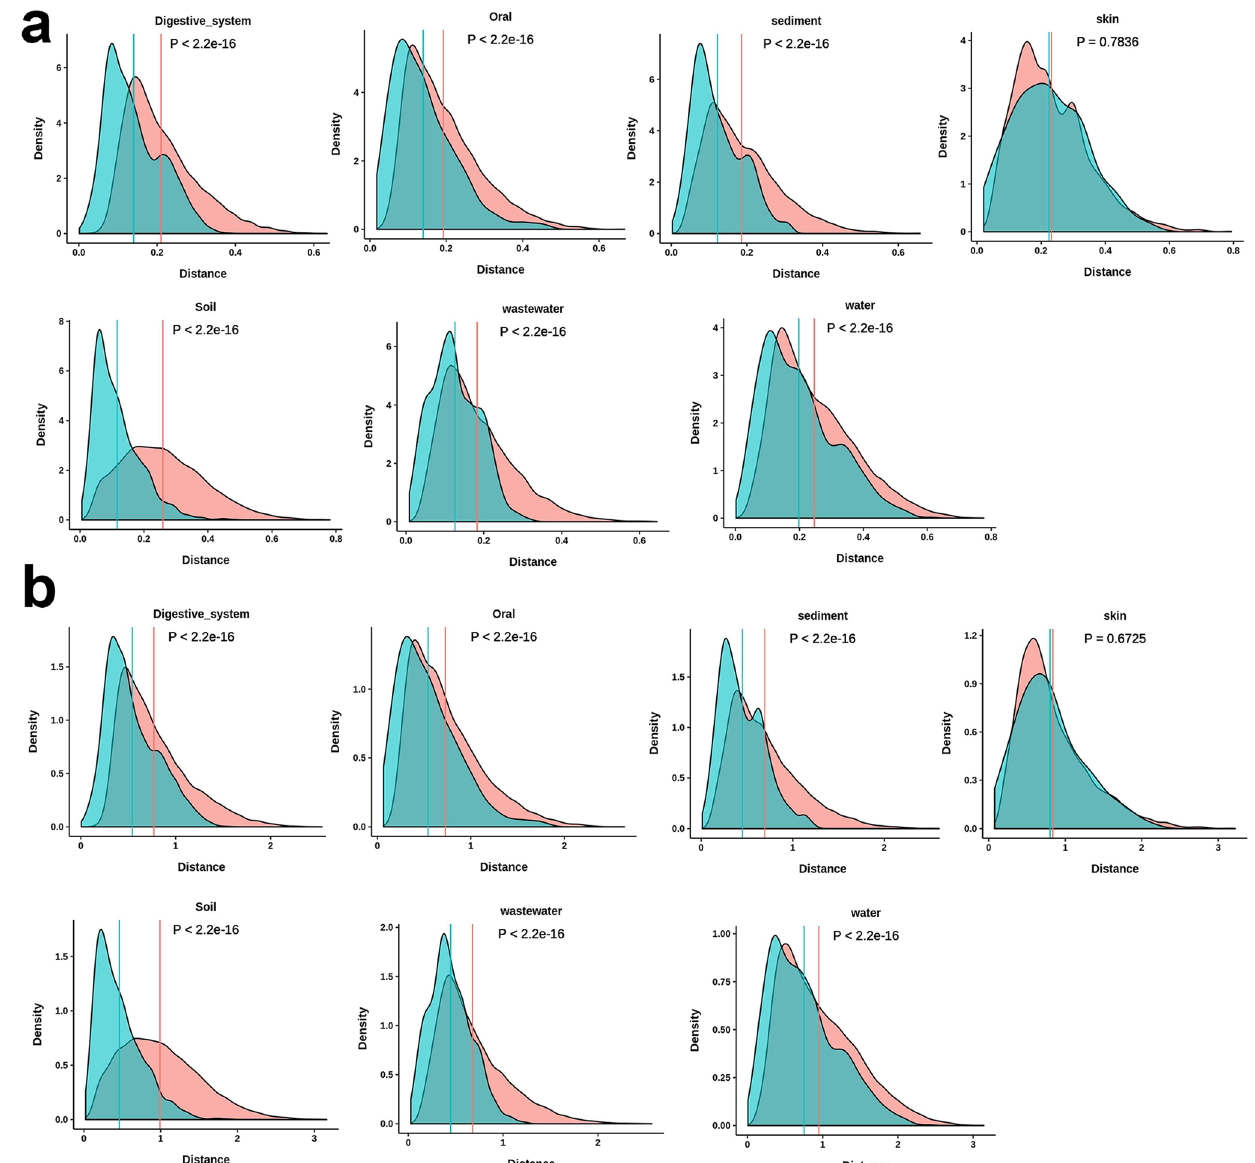
Fig. 2 Density plots showing codon usage distances among the samples calculated by Endres – Schindelin method. This fi gure shows the density plots of codon usage distances among samples from seven selected ecological niches. a Codon frequencies were calculated as absCUFs. b Codon frequencies were calculated as synCUFs. For each sample in each selected habitat, we calculated all possible pairwise codon usage distances with all other samples either from the same (within-group comparison) or different habitats (between-groups comparison). Next, we compared the within-group distances of codon usage with that of between-group distances habitat-wise. Statistical signi fi cance of the differences for pairwise comparison of within to between-group distances was accessed by Mann-Whitney U test and the corresponding P values were shown in the respective panel. In each panel, vertical lines represent the average of within and between-group distances in codon usage frequencies, respectively. Blue line stands for within-group distances and pink for between-group distances,